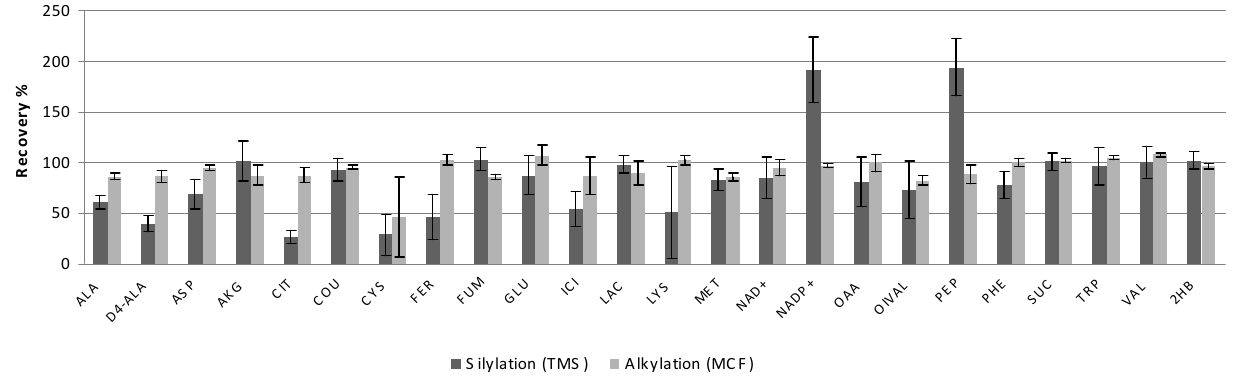
Figure 6. Recovery of the metabolite standard spiked on a spent microbial culture medium after silylation and alkylation derivatizations. See Table 1 for metabolite abbreviations.